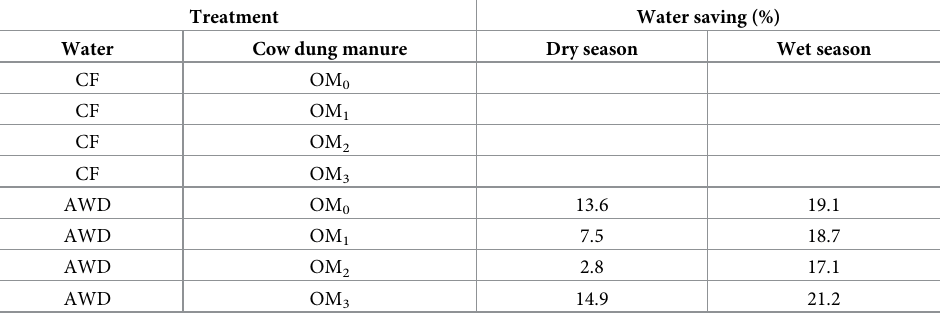
Table 7. Comparison of water saving of rice as affected by water and cow dung manure management during dry and wet seasons,